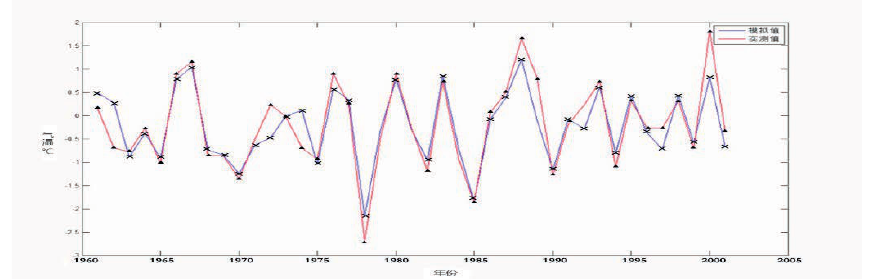
Fig. 2 Optimal temperature simulation based on